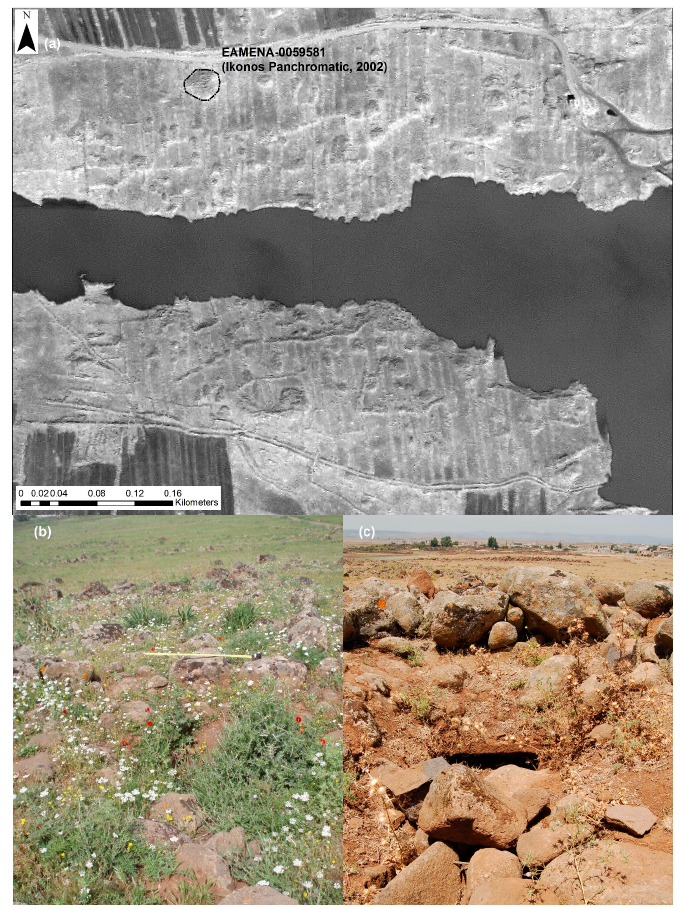
Figure 16. EAMENA-0059581 (( a ) Panchromatic Ikonos 2 March 2002; ( b ) 2007; ( c ) 2008).